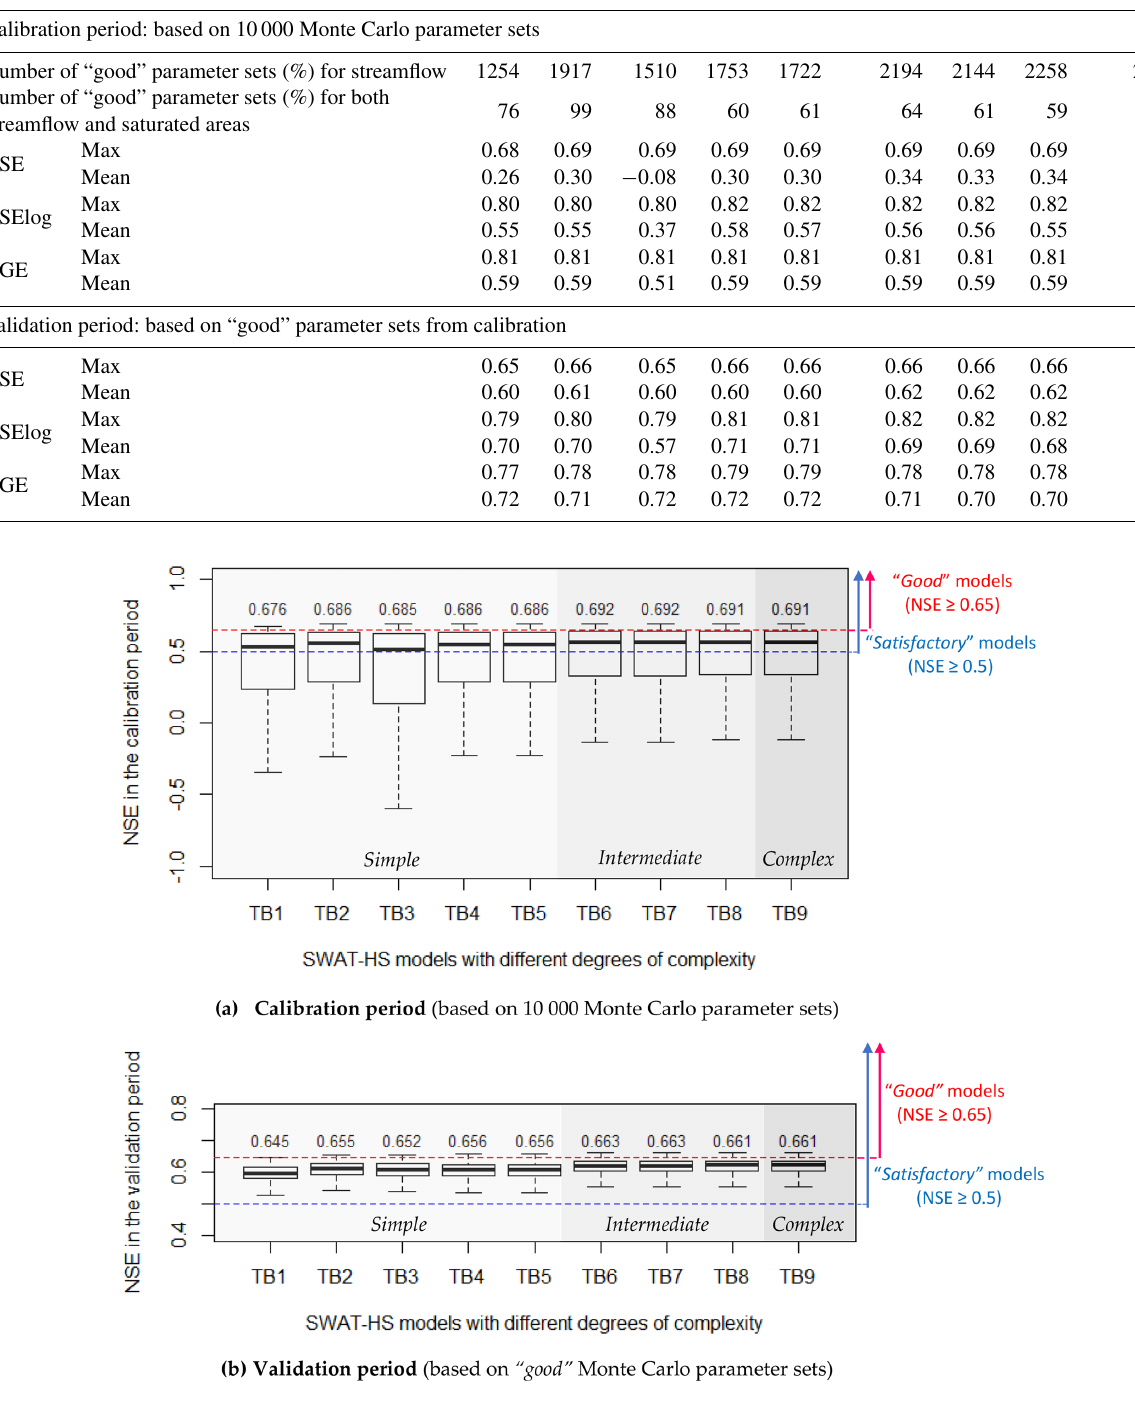
Figure 10. Box plots of NSE values in SWAT-HS setups with different degrees of complexity for calibration and validation periods (the number above the box plot is the maximum NSE of each